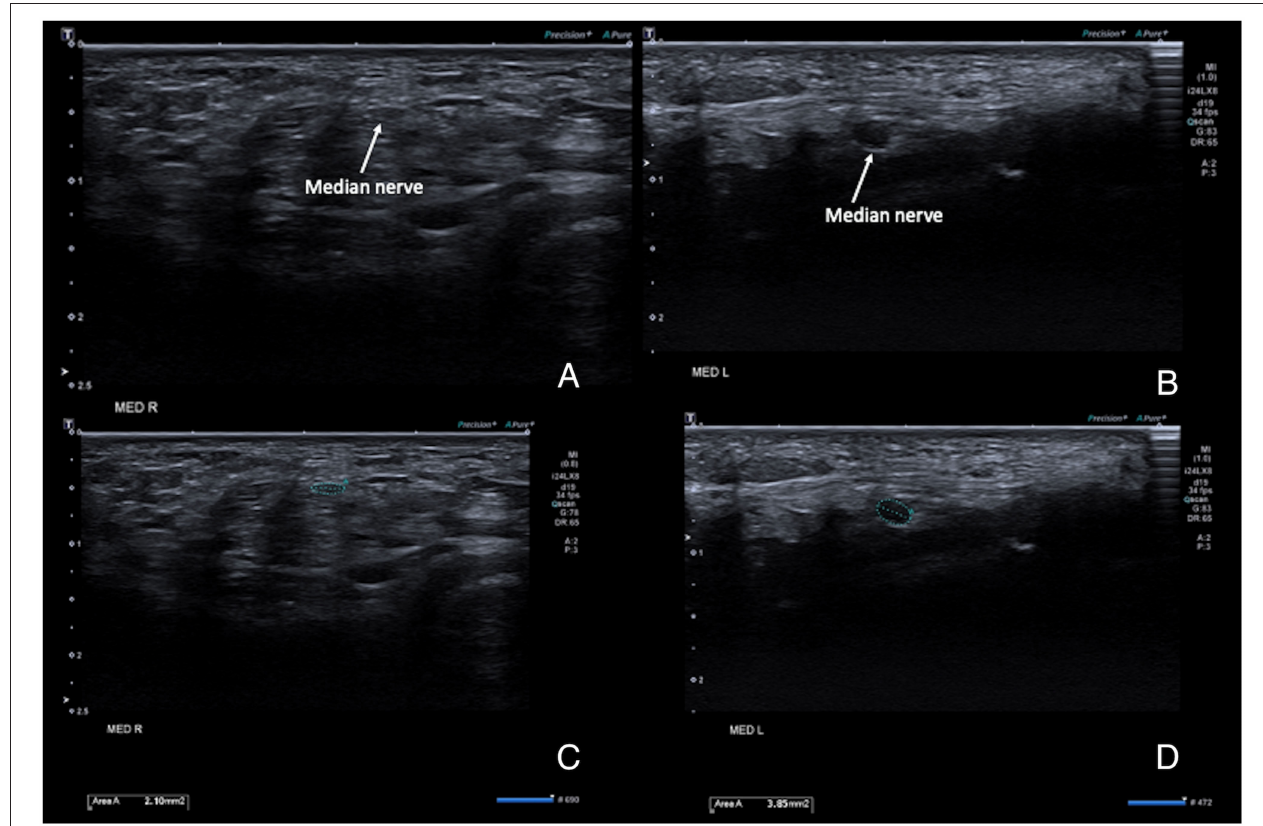
FIGURE 4 | High-resolution ultrasound images of the right (A,B) and left (C,D) median at the level of the carpal tunnel inlet at the wrist. (A,C) show the anatomical configuration, with a very small nerve size bilaterally, but a comparatively hypoechogenic and enlarged aspect of the nerve on the left. (B,D) show the same images with the cross-sectional area measurements superimposed. Normal adult average reference CSAs of the median nerve at the level of the carpal tunnel inlet vary from 6–9 mm 2 . obviate the need for many of these fibers as there is no skin area to